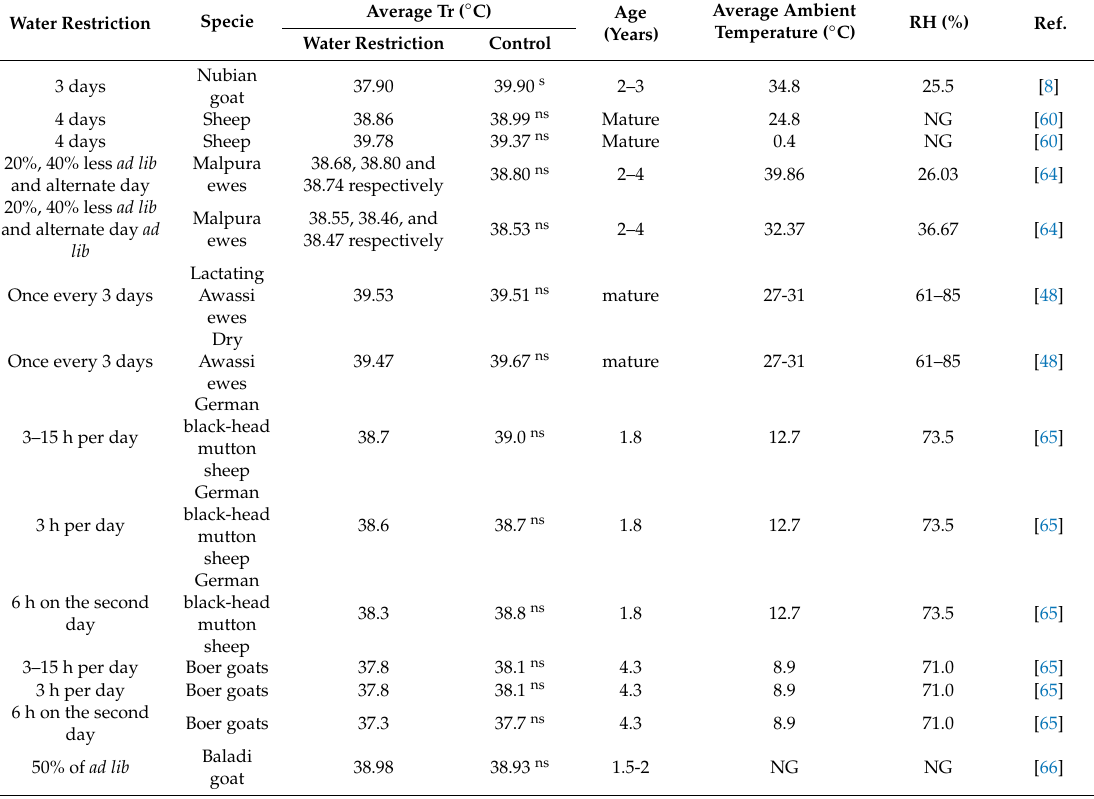
Table 2. E ff ect of water restriction regimen on rectal temperature in small ruminants.